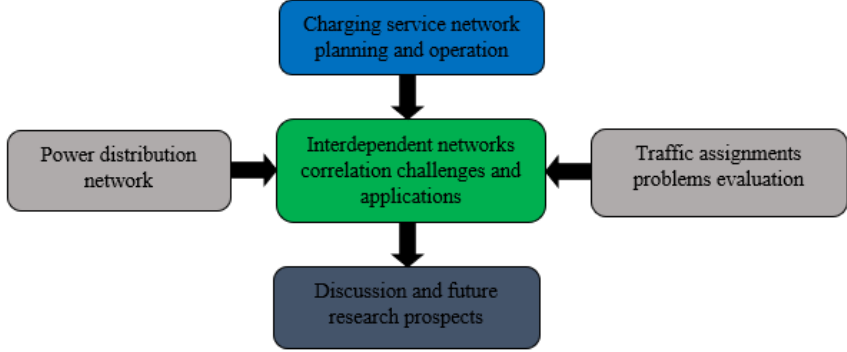
Figure 2. A study evaluation framework of interdependent networks.